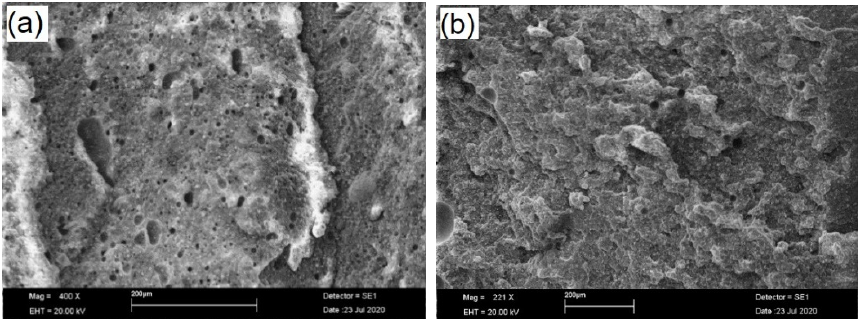
Figure 4. SEM images (low magnification, 400×) of the fracture surface of neat endodontic sealer ( a ) and modified sealer after incorporation of CNTs/CHX/AgNPs ( b ).